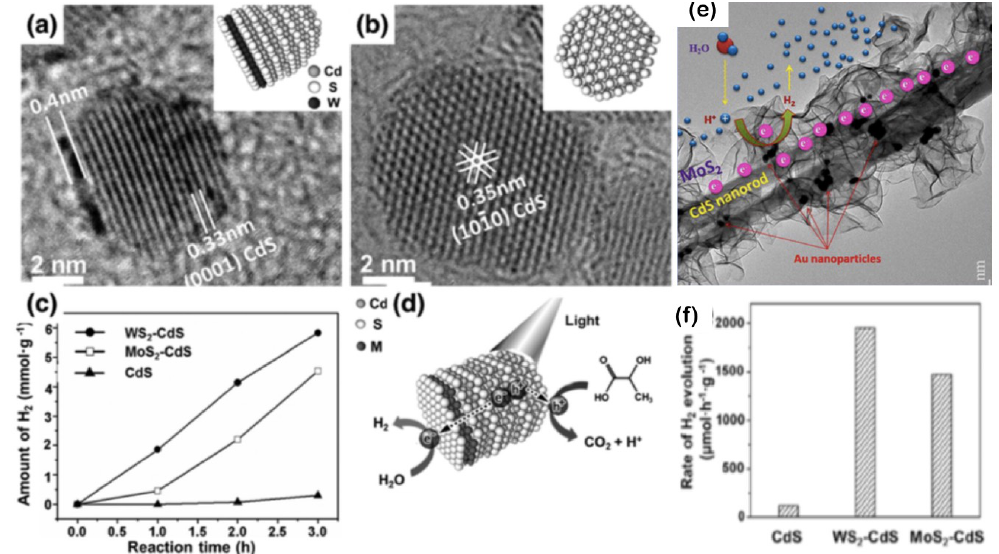
Figure 9. HR-TEM images of WS 2 –CdS hybridized nanomaterial from ( a ) perpendicular view and ( b ) parallel side view; ( c ) H 2 production of hybridized nanomaterials. ( d ) The simplified schematic of the photocatalytic process for WS 2 –CdS hybridized nanomaterial in lactic acid